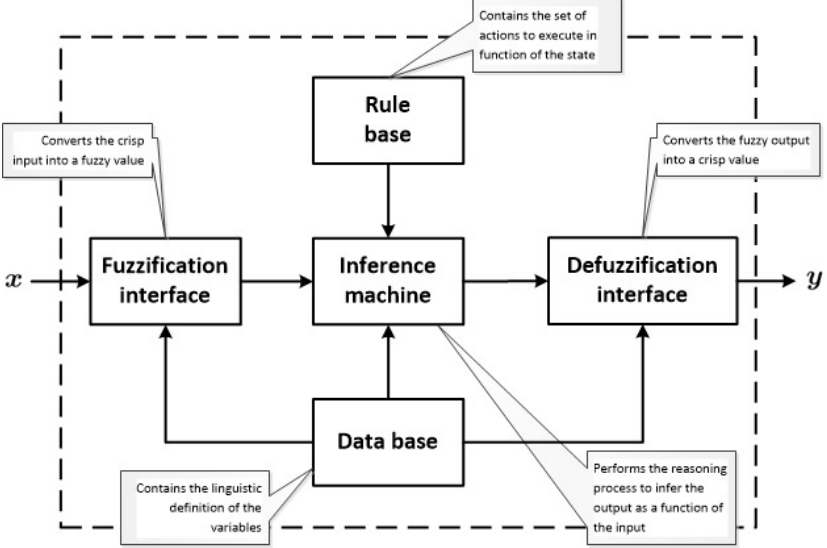
Figure 4. Internal diagram of an FLC showing all the elements that compute its